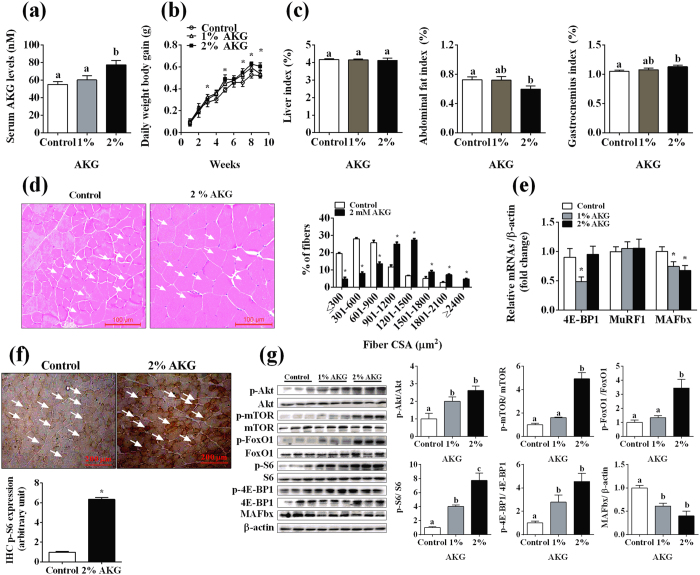
Effects of α-ketoglutarate on skeletal muscle weight and fiber size in C57 BL mice.Thirty 5-week-old mice were randomly divided into three groups (n = 10). Different concentrations of AKG (0%, 1% and 2%) were supplemented via drinking water for 9 weeks. (a) Serum AKG level examined by AKG assay kit. (b) Mice daily body weight gain. (c) Liver index, abdominal fat index, and gastrocnemius index. (d) Representative images of gastrocnemius muscle stained by H&E and gastrocnemius muscle fiber area distribution. The place of arrows direction represented muscle fiber. (e) Relative mRNA expression detected by qPCR. (f) Phosphorylation levels of Akt mTOR, S6, 4E-BP1, FoxO1, and the expression of MAFbx by Western blot. (g) The phospho-S6 protein expression examined by IHC in the gastrocnemius of mice. The place of arrows direction represented the expression of phospho-S6. Data are presented as mean ± SEM. Different superscripts “a”/“b”/“c” represent significant differences between groups (P < 0.05), and *means P < 0.05 compared with the control. β-actin served as a housekeeping gene.